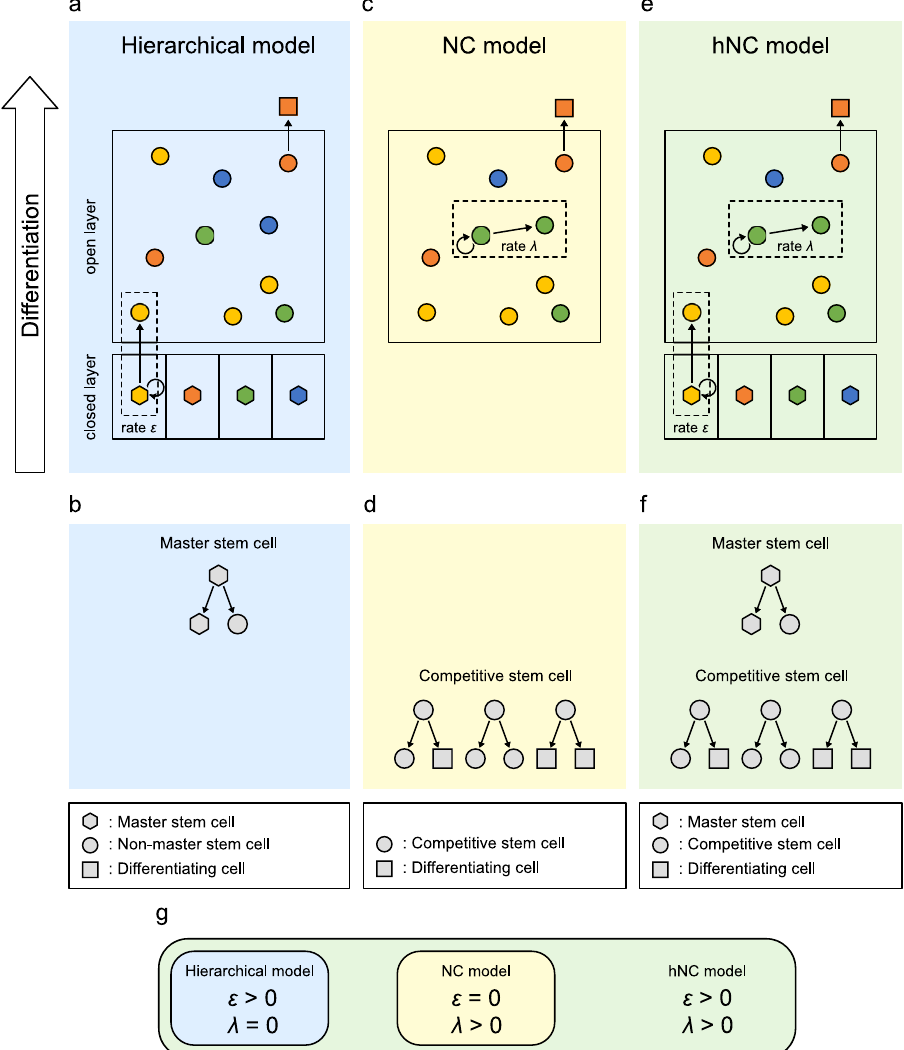
Fig. 1 Three distinct biological models for stem cell homeostasis. a Hierarchical model. Loss of stem cells is compensated for by asymmetric division of master stem cells (hexagon) in the closed layer. In the open layer, non-master stem cells (circles) do not compete with each other and are directed to differentiation. Each color indicates each clone derived from the common master stem cell. b Diagram of patterns of stem cell divisions in the hierarchical model. c NC model. Loss of stem cells is compensated for by proliferation of competitive stem cells (circles) in the open layer. Each color indicates each clone derived from the common competitive stem cell. d Diagram of patterns of stem cell divisions in the NC model. e Hierarchical neutral competition (hNC) model. Loss of stem cells is compensated for by the asymmetric division of master stem cells (hexagon) in the closed layer and proliferation of competitive stem cells (circles) in the open layer. Each color indicates each clone derived from the common master stem cell. f Diagram of patterns of stem cell divisions in the hNC model. g Relationships between the three models. The mathematical model seamlessly represents all three biological models based on two parameters, ε and λ , which represent the proliferation rates of master stem cells and competitive stem cells,